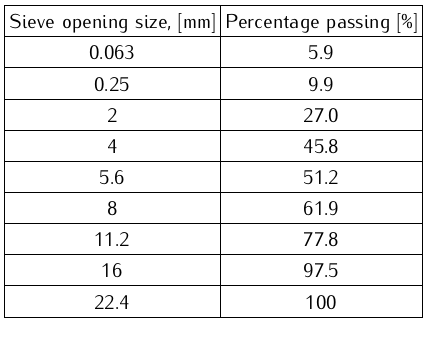
Table 2. Aggregate grading of tested AC 16 asphalt mix